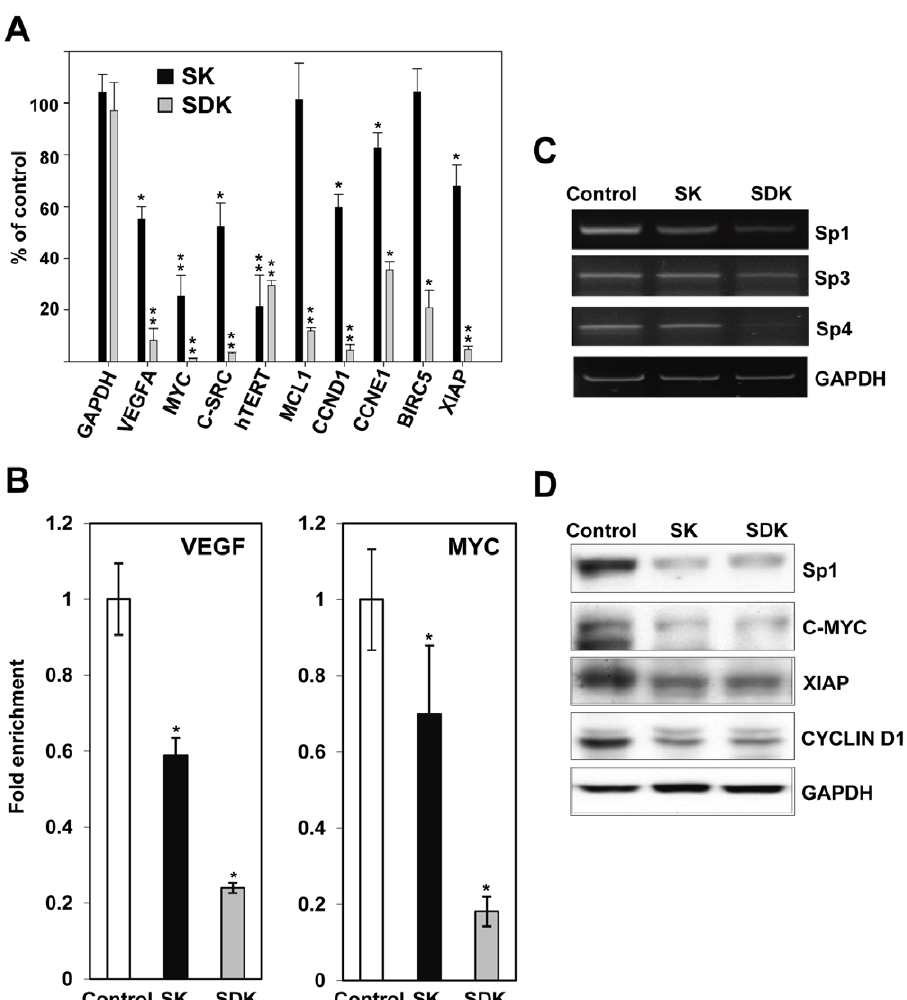
Figure 1. Inhibition of Sp regulated genes by MTM-SDK and MTM-SK in prostate cancer cells invitro . PC3 cells were treated with 100 nM of MTM-SDK, MTM-SK or vehicle (DMSO) for 24 h. A) Gene expression was measured by qRT-PCR. Data were normalized to B2M RNA level and are presented as percentage of expression compared to vehicle-treated cells (control). Data represent the mean 6 SD from 3 independent experiments. B) Binding of Sp1 to the promoters of C-MYC and VEGF in control and drug treated cells was determined by ChIP using an anti-Sp1 specific antibody. DNA in input and immunoprecipitated fractions was quantified by qPCR with primers encompassing the Sp binding site in the gene promoters. Data (mean 6 SD) from 3 independent experiments are expressed as percentage of input DNA in immunoprecipated fractions. *, P , 0.01; **, P , 0.001. C) Level of Sp1, Sp3 and Sp4 mRNA was determined by RT-PCR in PC3 cells incubated with 100 nM of MTM-SDK, MTM-SK or vehicle for 24 and 48 h. GAPDH was used as control. D) Protein level of Sp1, c-Myc, XIAP, and cyclin D1 was determined by immunoblotting in PC3 cells incubated with 100 nM of MTM-SDK, MTM-SK or vehicle for 24 and 48 h.